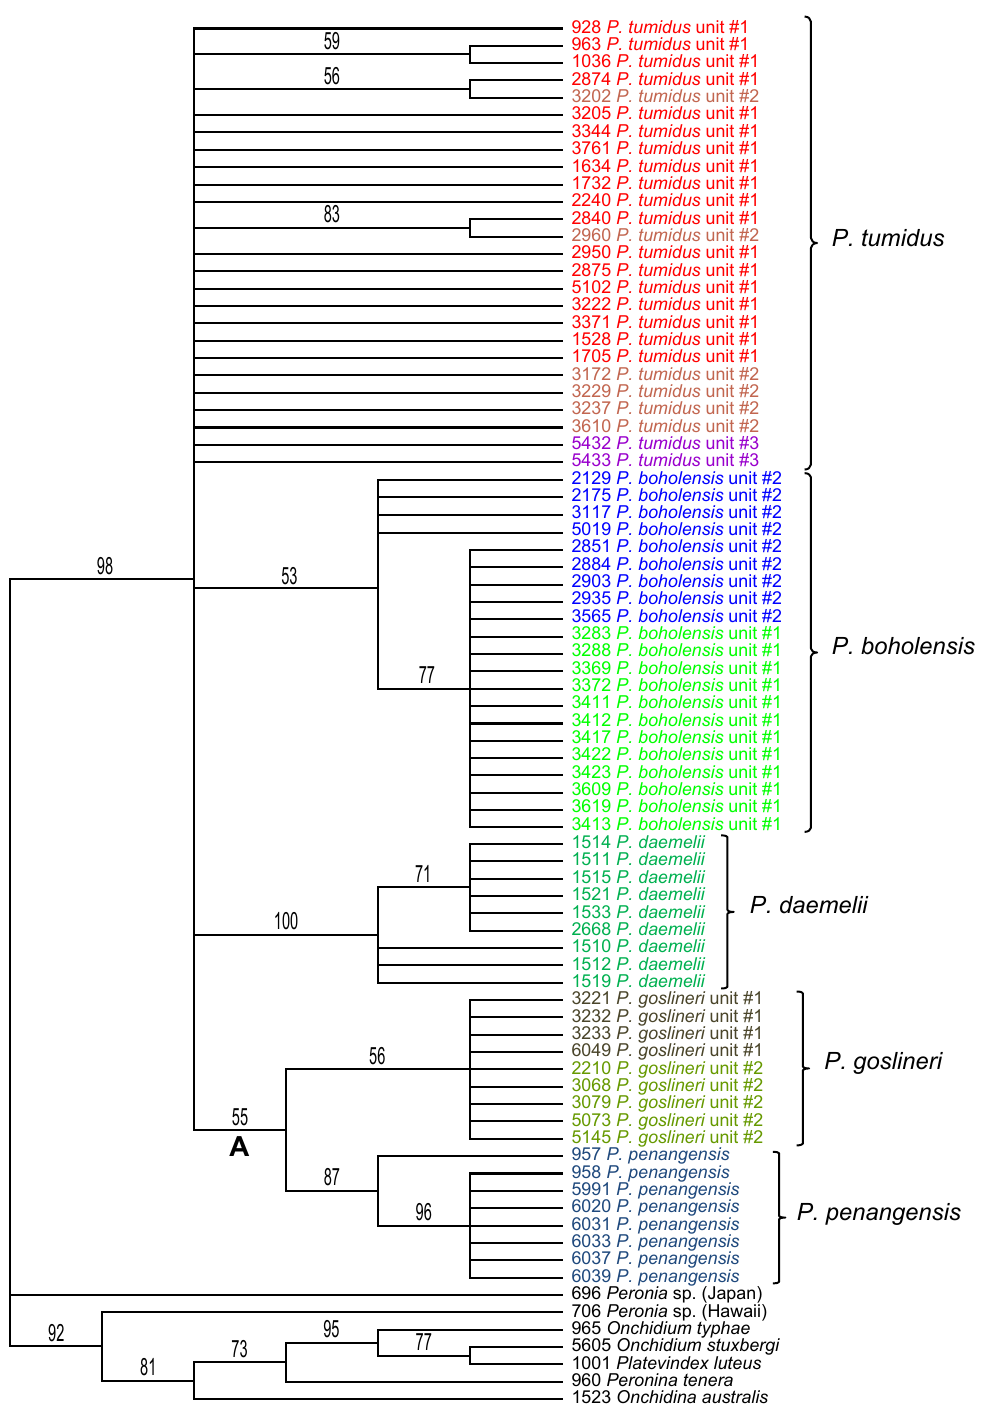
Fig. 4. Maximum parsimony consensus tree within Paromoionchis gen. nov., performed with ITS2 DNA sequences from 80 individuals (including 7 outgroups). Numbers by the branches are the bootstrap values (only numbers > 50% are indicated). Numbers for each individual correspond to unique identifiers for DNA extraction. All sequences for specimens of Paromoionchis gen. nov. are new. Information on specimens can be found in the lists of material examined and in Table 1. The letter A corresponds to a clade referred to in the text. The color used for each (mitochondrial) unit is the same as that used in Figs 1–3 and